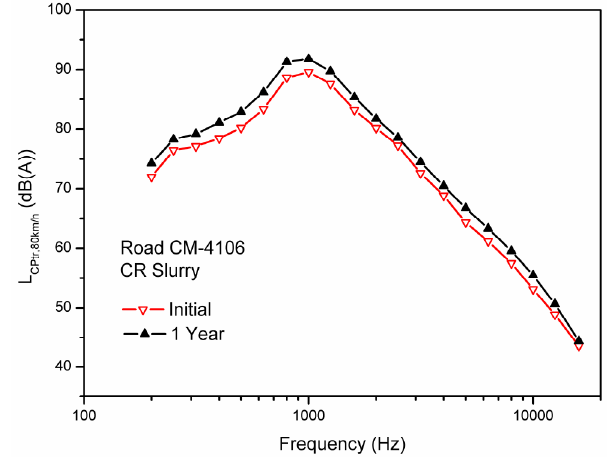
Figure 6. Time evolution of tire/road noise. Spectra at a reference speed of 80 km/h associated to the experimental bituminous slurry with crumb